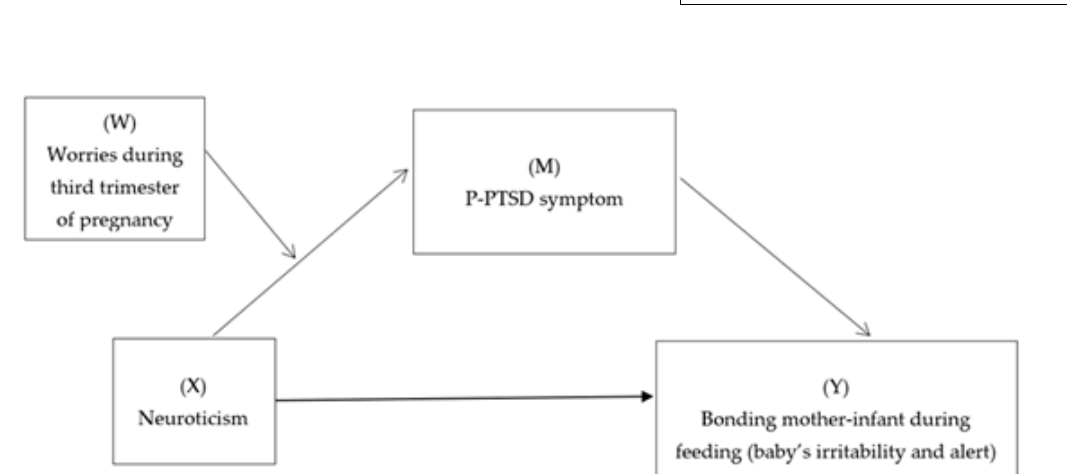
Figure 1. Conceptual moderated-mediation model.